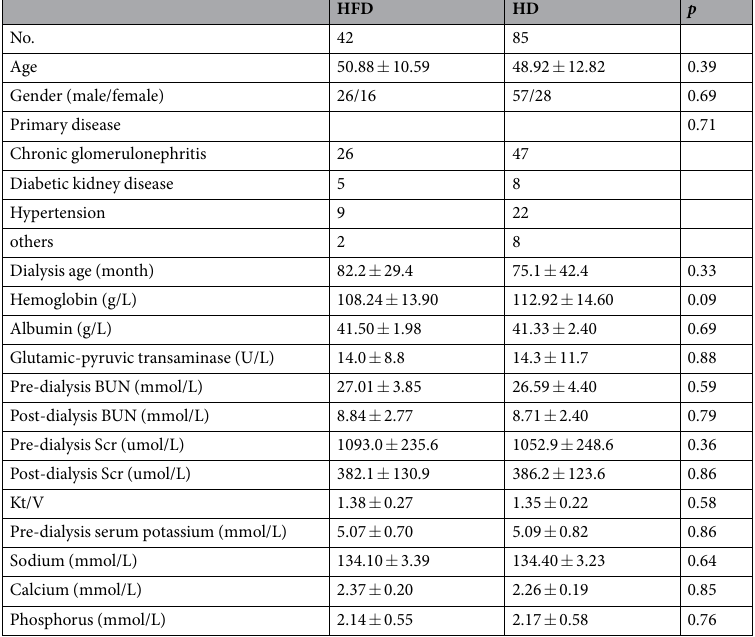
Table 1. Basic clinical characteristics of the samples in the research set. Data are presented as mean ±